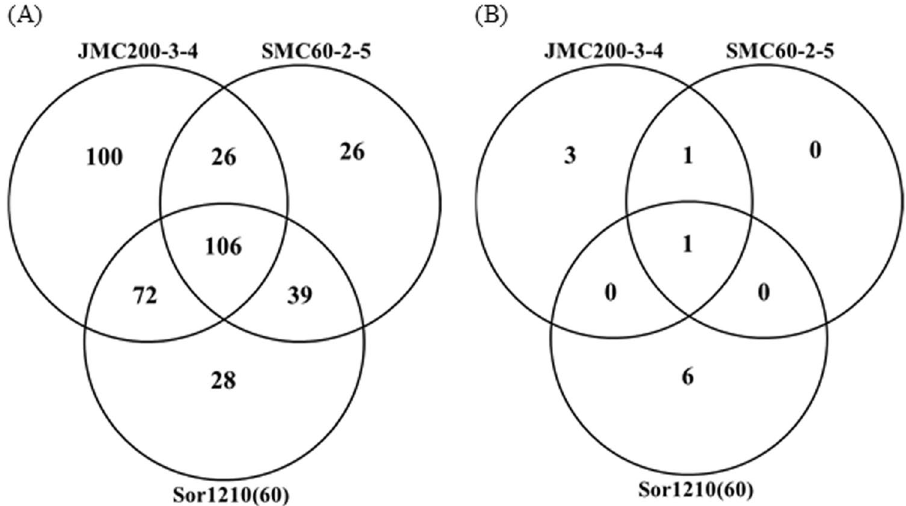
Figure 2. Venn diagrams showing 369 genes that were differentially expressed by CuffDiff2 at p < 0.05 on the monosomic Ch5 in a total of three caspofungin-tolerant mutants JMC200-3-4, SMC60-2-5, and Sor1210(60). Numbers in intersections of the circles represent the number of shared genes, while the number in the larger part of the circle represents the genes unique to that particular mutant. ( A ) Downregulated genes. ( B ) Upregulated genes.